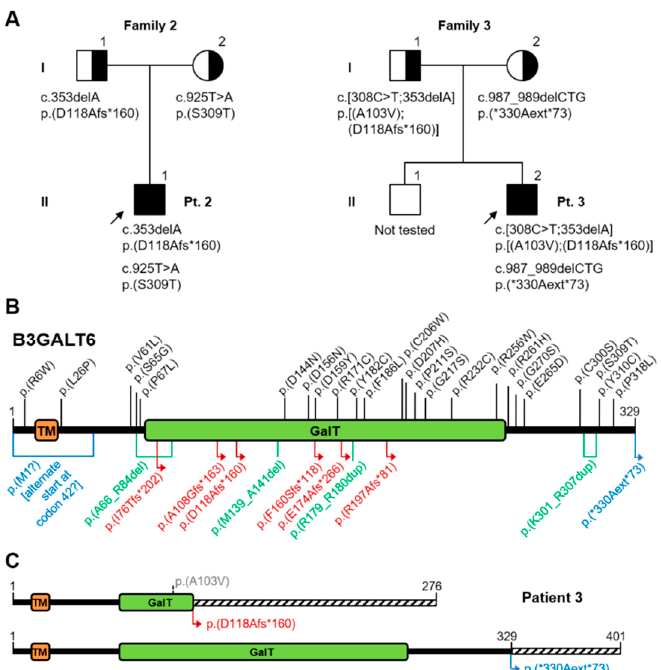
Figure 7. A ) Pedigree of Families 2 and 3; B ) Schematic representation of the B3GALT6 protein: TM = transmembrane domain, GalT = Galactosyl-transferase catalytic domain. Protein variants reported in the literature are annotated in the cartoon (see Table 2 for references). Top half: missense variants (black). Bottom half: frameshift variants (red), in-frame indels (green), other length-altering variants (blue); C ) Protein projection of the two alleles from Pt.3; dashed boxes indicate an altered or extended reading frame.